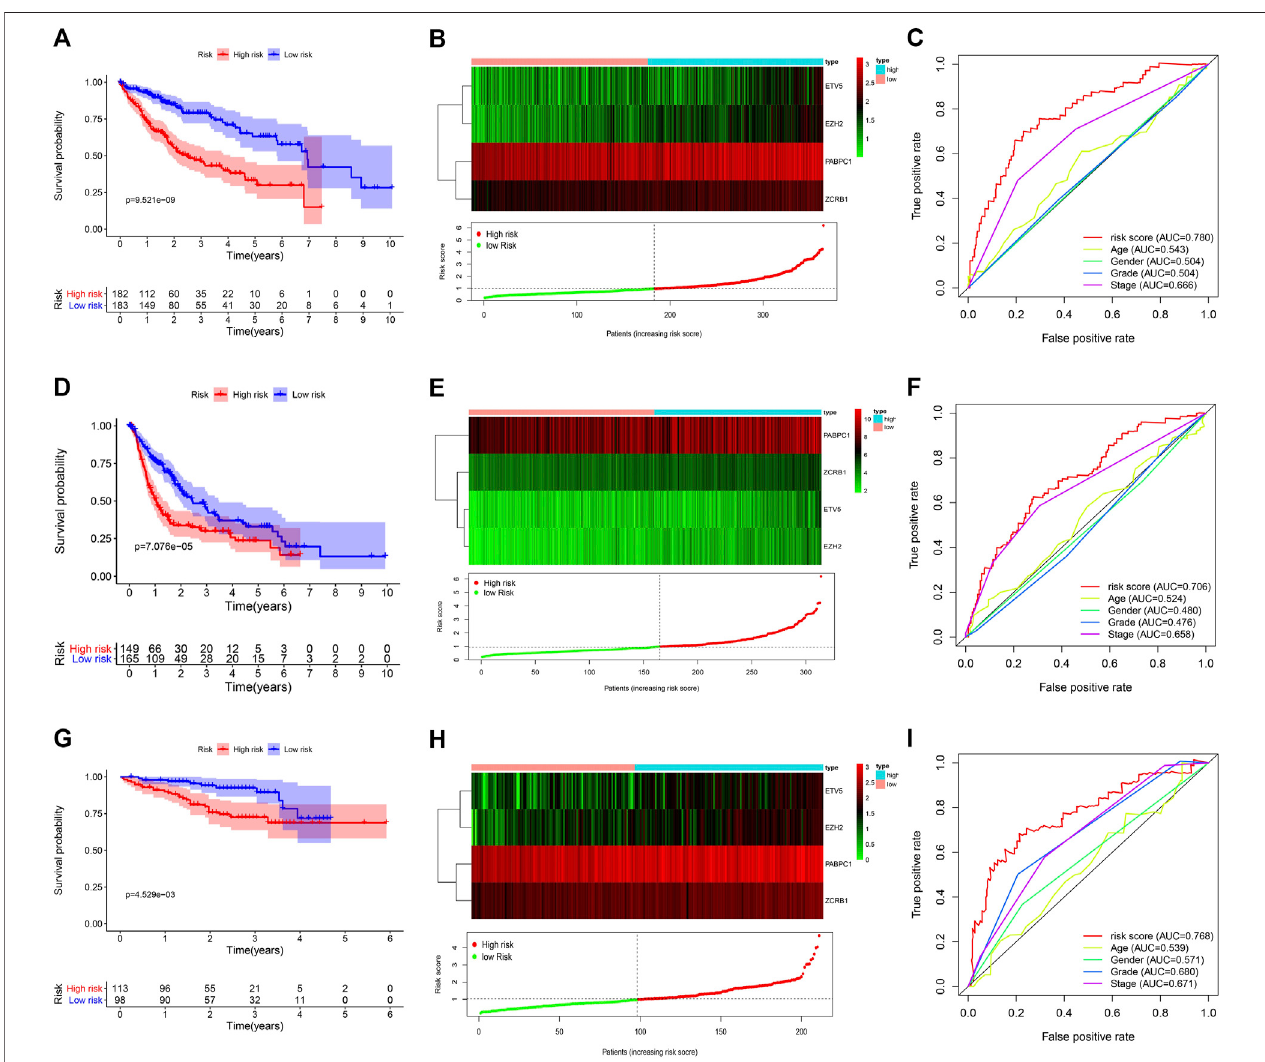
FIGURE4| SurvivalanalysisandsensitivityvalidationoftherisksignatureintheTCGAandICGCcohort. (A) OSanalysisofdifferentriskgroupsintheTCGAcohort. (B) The expression distribution of risk genes in TCGA cohort. (C) The ROC curve validated the sensitivity and speci fi city of the risk score to predict patient OS in TCGA cohort. (D) DFS analysis of different risk groups in the TCGA cohort. (E) The expression distribution of risk genes in TCGA cohort. (F) The ROC curve validated the sensitivity and speci fi city of the risk score to predict patient DFS in TCGA cohort. (G) OS analysis of different risk groups in the ICGC cohort. (H) The expression distribution of risk genes in ICGC cohort. (I) The ROC curve validated the sensitivity and speci fi city of the risk score to predict patient OS in ICGC cohort.